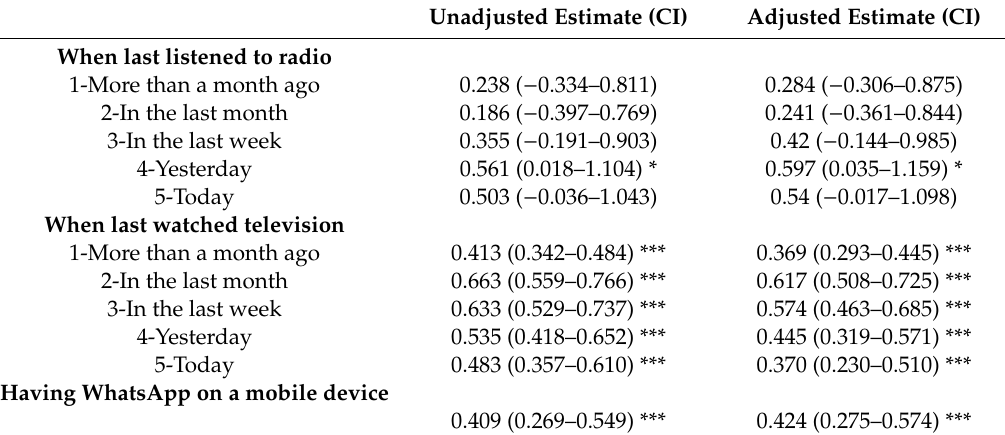
Table 5. When to wash baby’s hands knowledge indicators associated with media